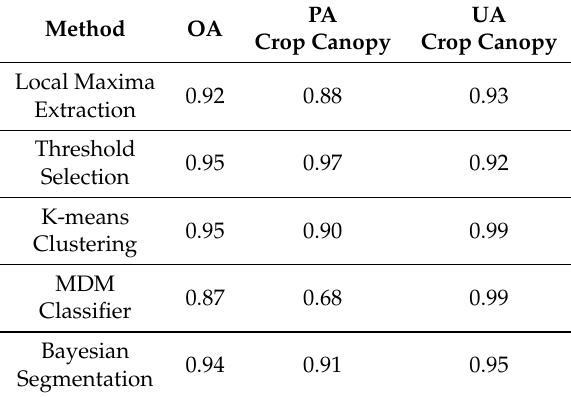
Table 8. Pear orchard site: assessment of the best results of each detection